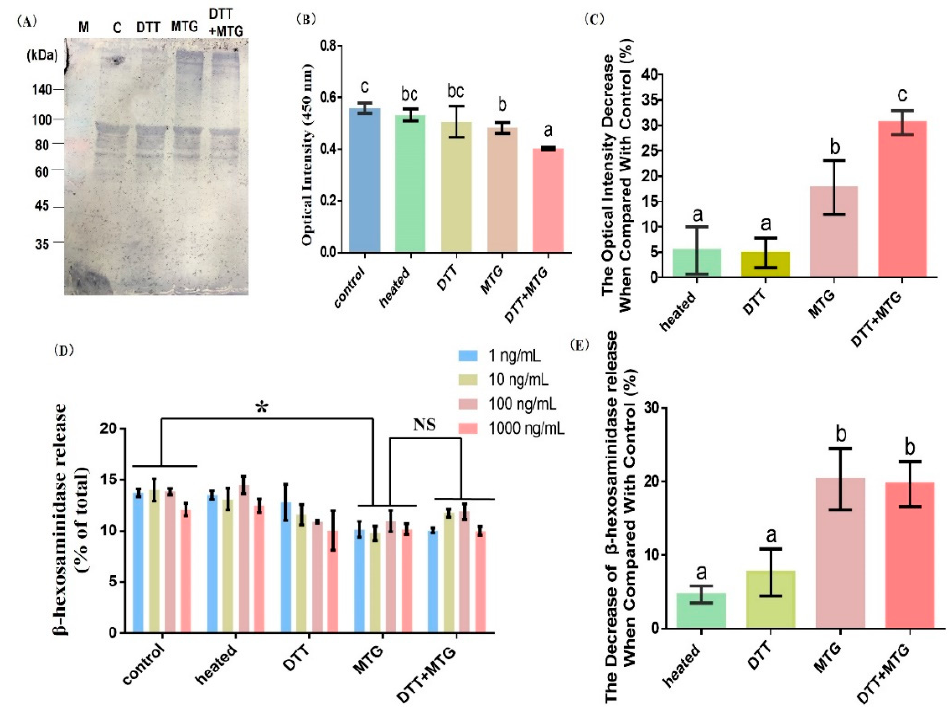
Figure 4. Immunoreactivity changes of rAra h 1 before and after modification. ( A ) Immunoblots by using rabbit anti-Ara h 1 antibody. ( B ) ELISA results by using pooled patients’ sera. ( C ) The decrease in IgE-binding e ffi ciency in di ff erent samples when compared with the control group. ( D ) β -hexosaminidase release of cells stimulated by protein samples. ( E ) The decrease in β -hexosaminidase release in di ff erent samples when compared with control group. M: protein marker, C or Control: rAra h 1 before modification, heated: rAra h 1 heated at 40 ◦ C for 5 h, DTT: rAra h 1 reduced by DTT, MTG: rAra h 1 cross-linked by MTG, DTT + MTG: rAra h 1 reduced by DTT first and then cross-linked by MTG. Results were considered significantly di ff erent from the control